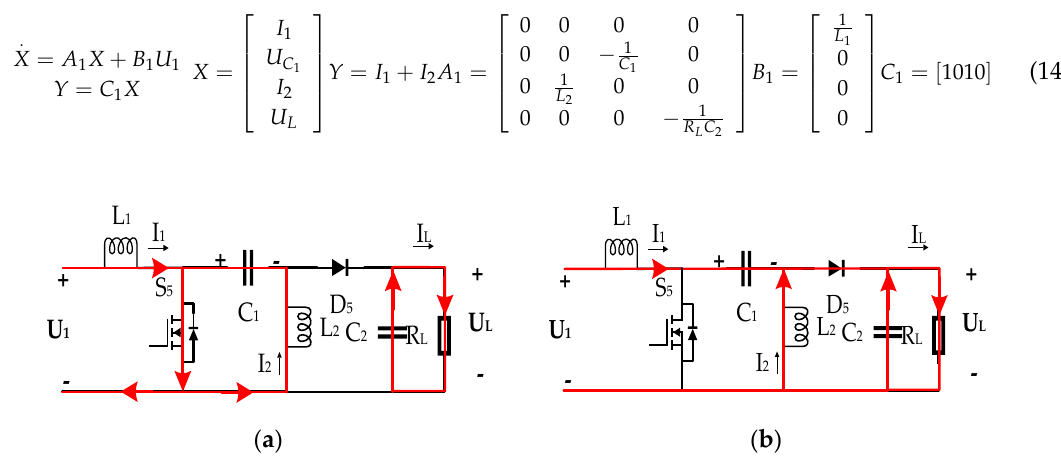
Figure 4. Topology of SEPIC circuit: ( a ) MOSFET S 5 is turned on; and ( b ) MOSFET S 5 is turned off.